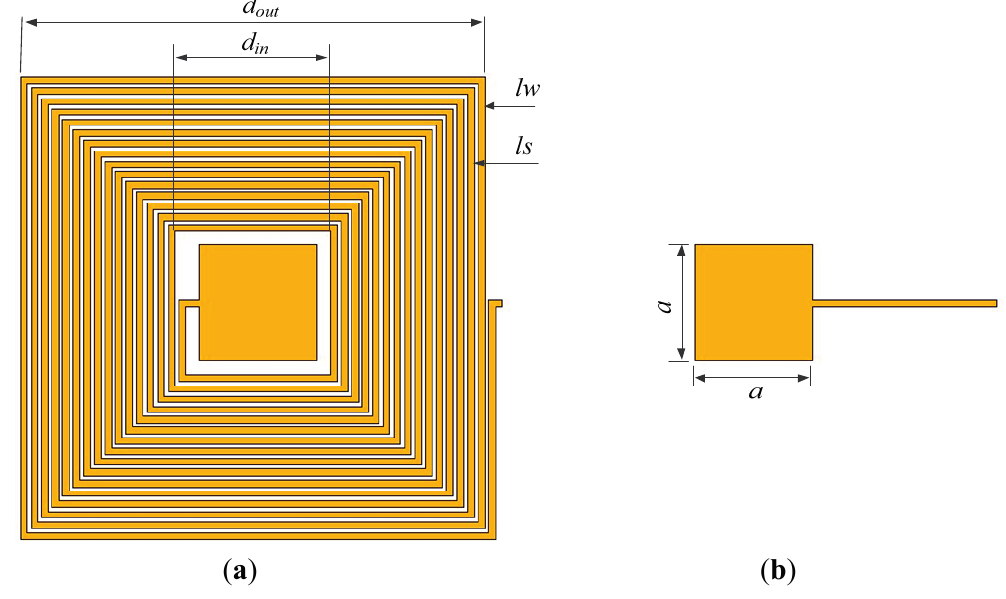
Figure 3. Design parameters of resonator: top electrode and inductance coil ( a ) and bottom electrode ( b ). d out and d in are the outer diameter and inner diameter of the inductor, respectively. lw , ls and lt are line width, line spacing and line thickness of the inductor. a : length of capacitor